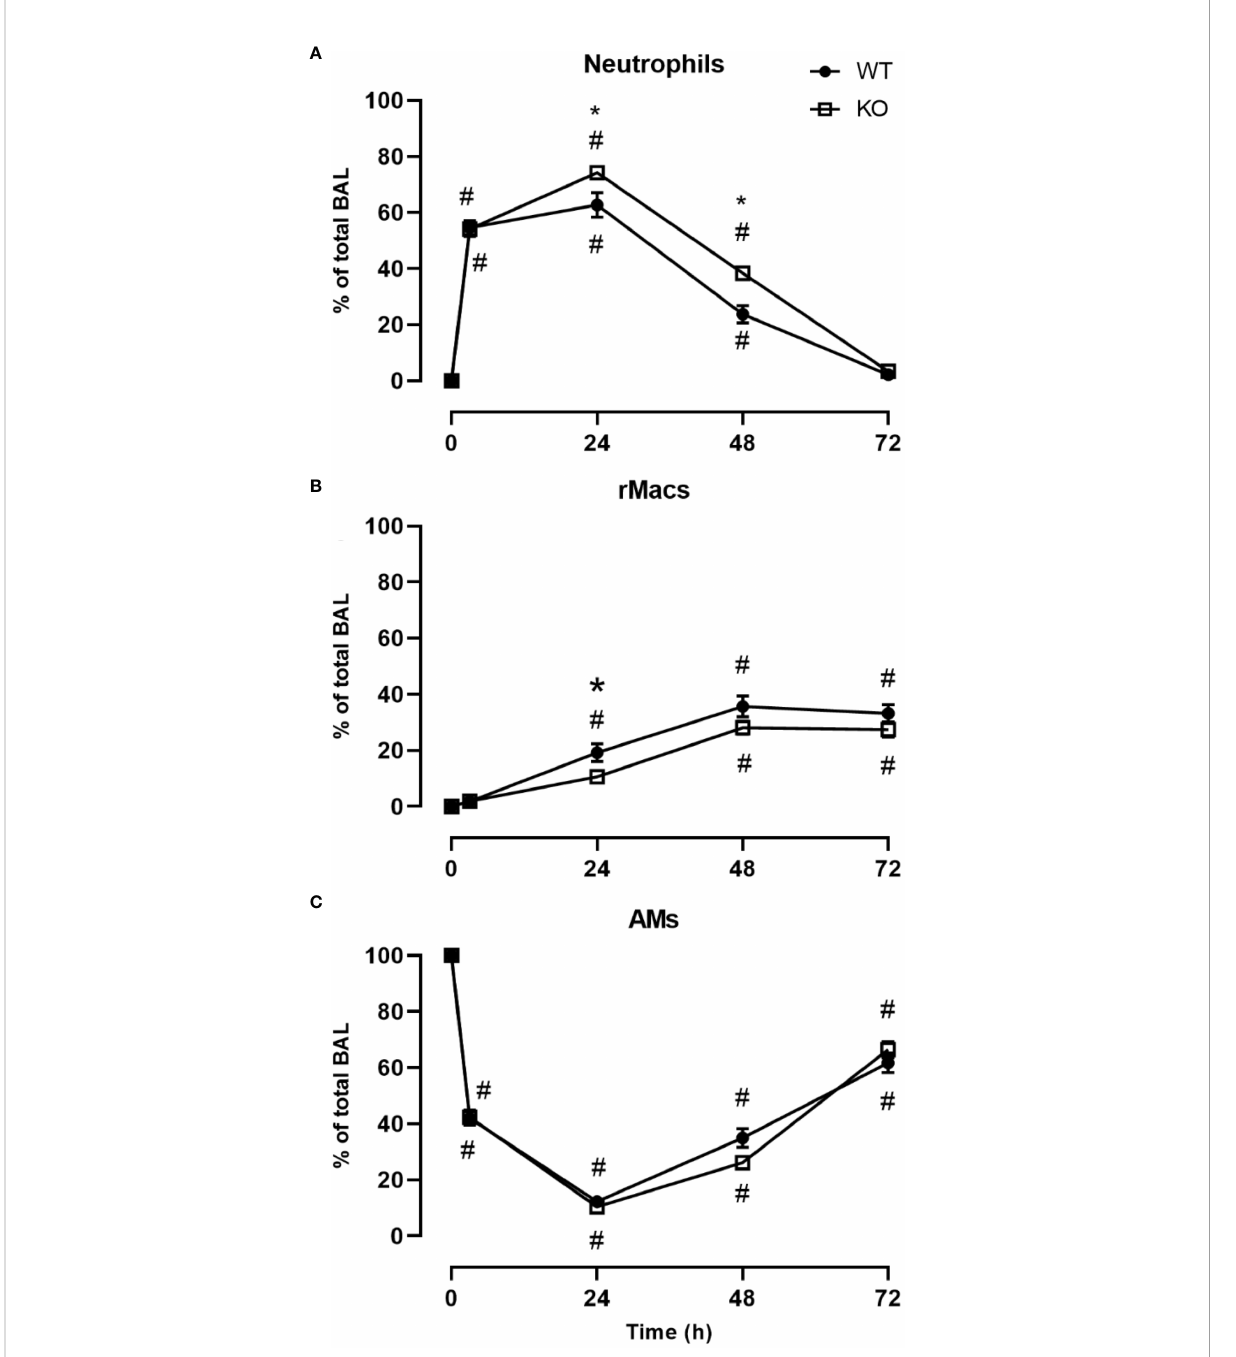
FIGURE 3 CD200 expression controls neutrophilic recruitment after LPS exposure. WT and CD200 KO rats were exposed to LPS intratracheally. BAL cell types were identi fi ed using fl ow cytometry, including, (A) Neutrophils, (B) recruited in fl ammatory macrophages (rMacs), and (C) alveolar macrophages (AMs). Data are from individual rats, with n = 6-8 per group of two independent experiments. Statistical signi fi cance was determined using two-way ANOVA followed by Bonferroni ’ s multiple comparisons; *P < 0.05 vs WT; # P < 0.05 vs